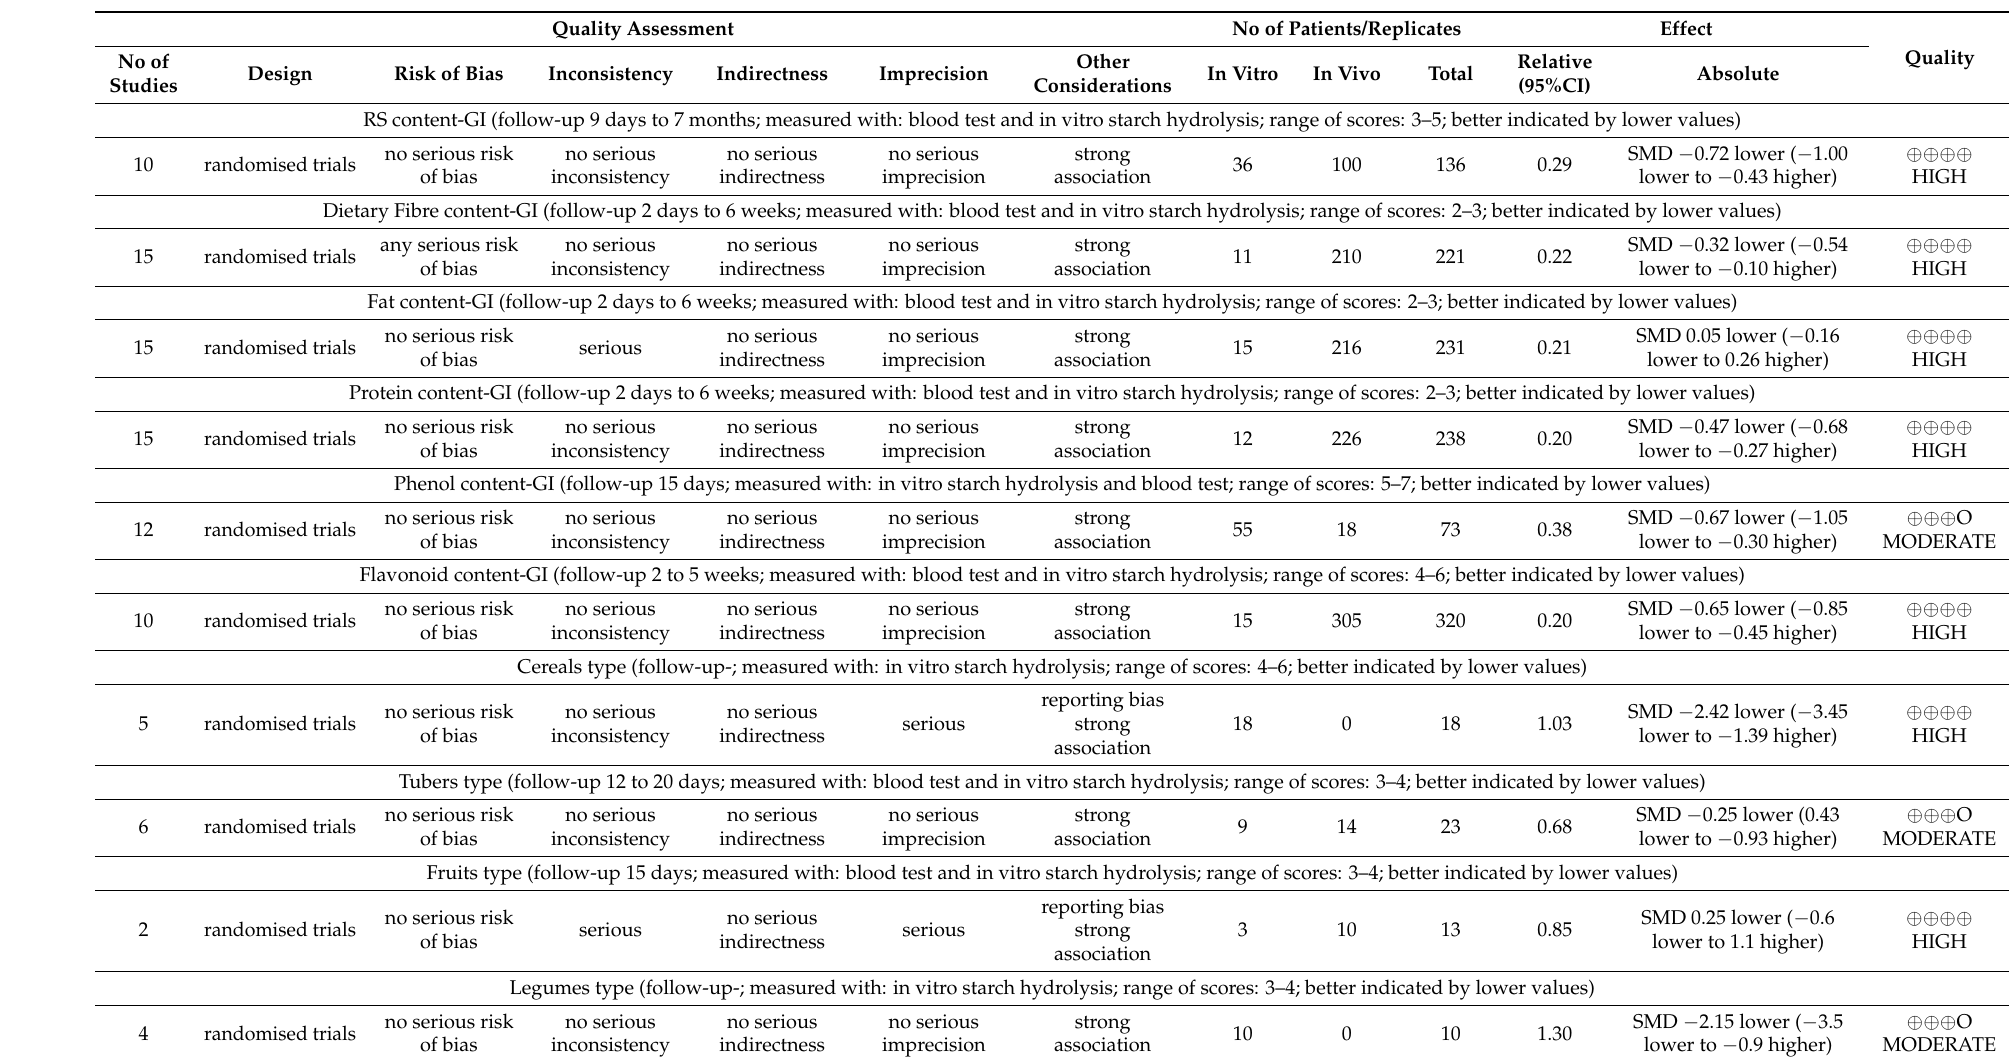
Table 1. GRADE evidence profile for chemical properties and starchy food sources related to